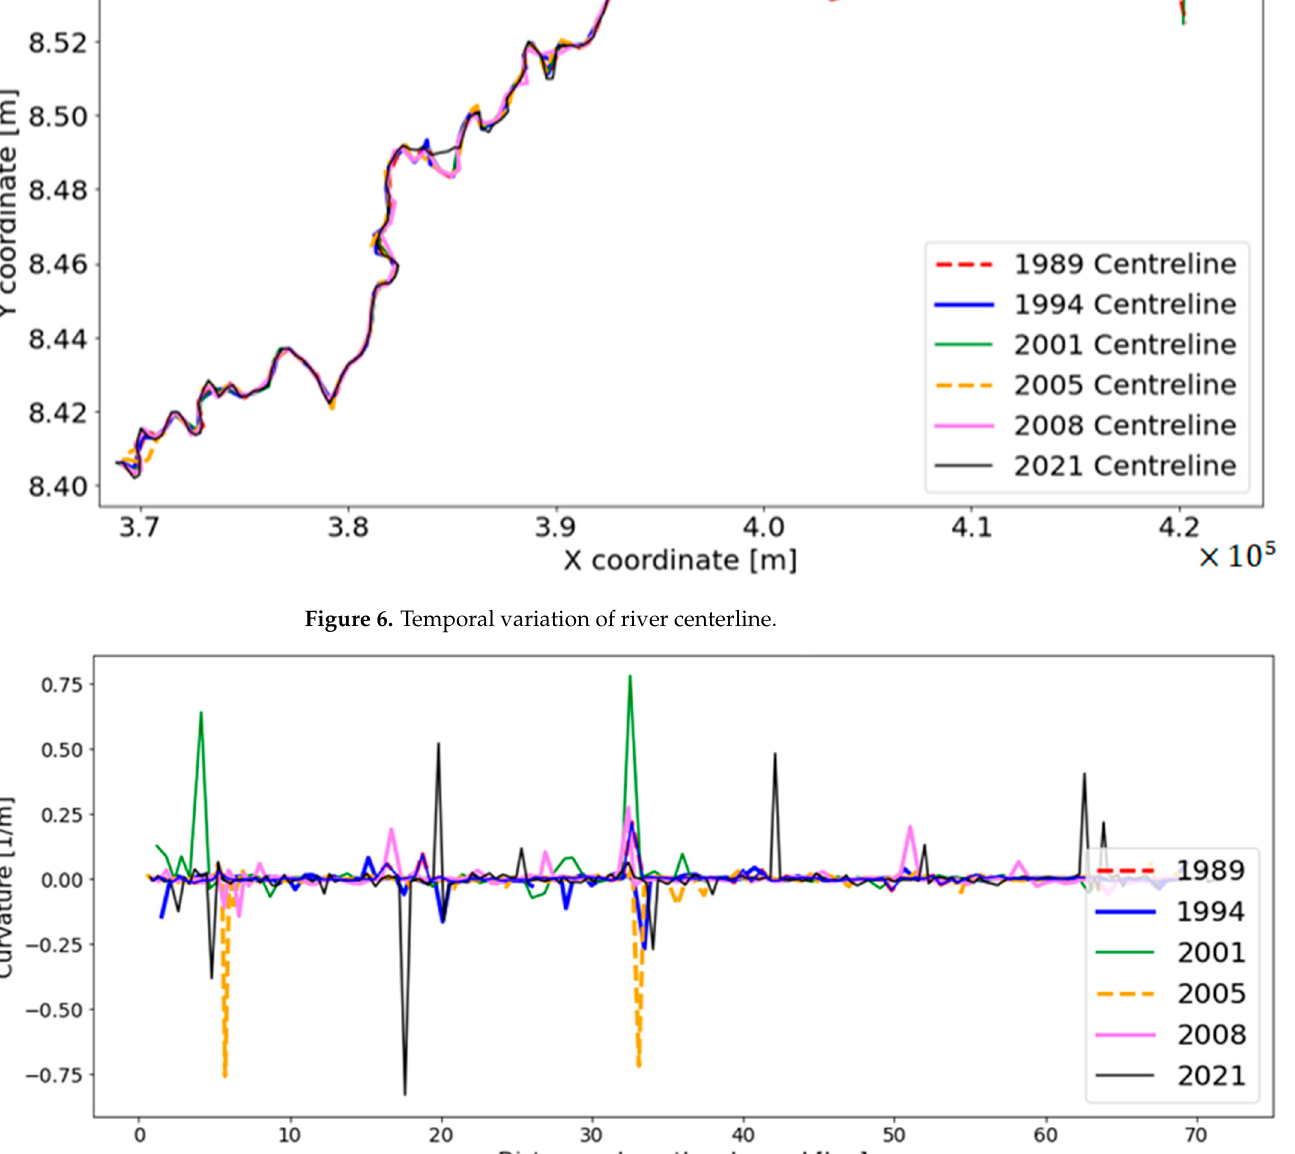
Figure 7. Spatiotemporal variation of curvature along the river centerline.